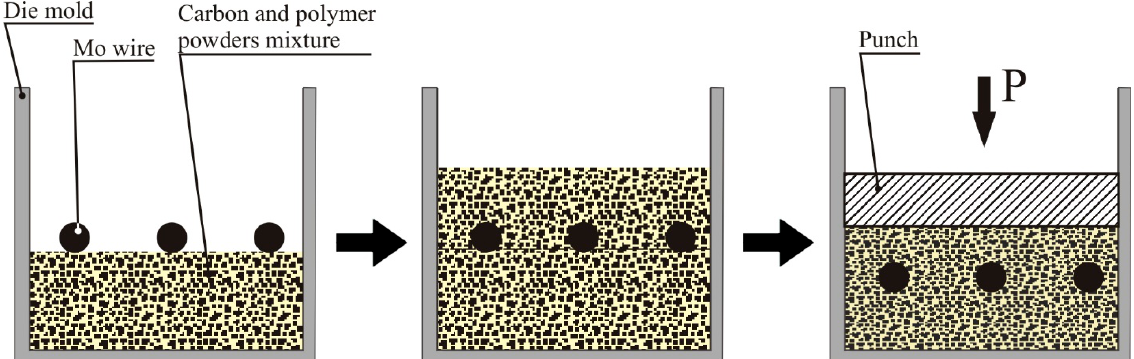
Figure 2. Scheme for obtaining blanks reinforced with molybdenum wire.